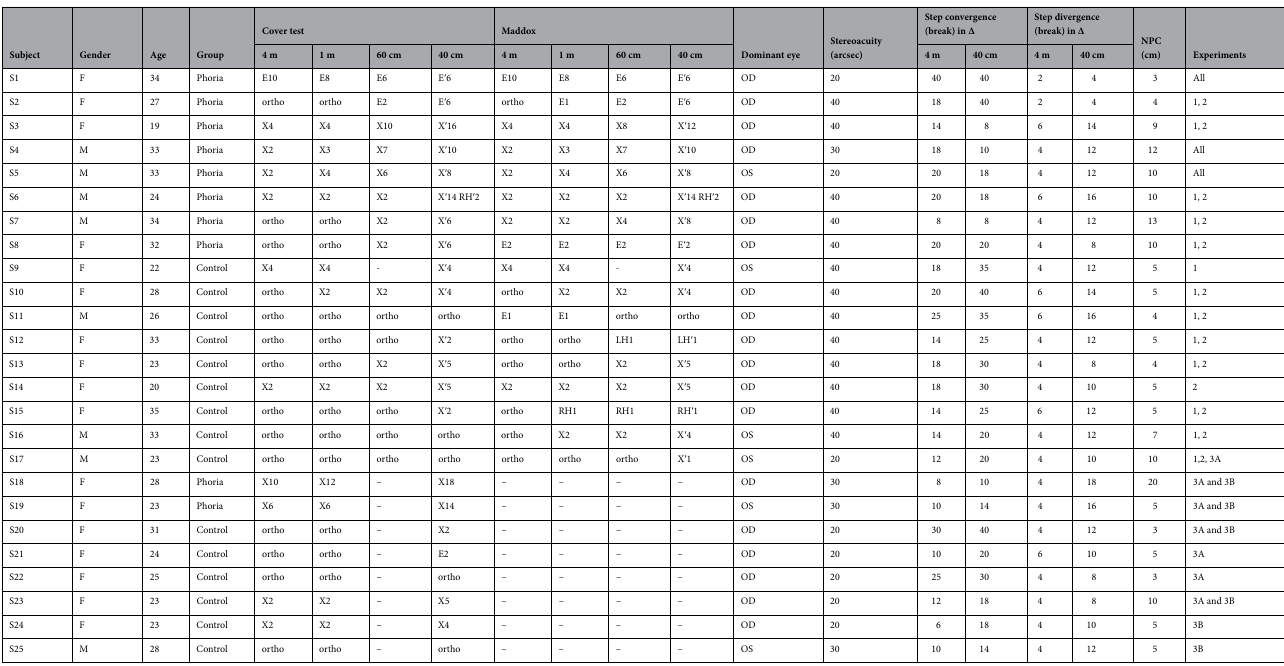
Table 1. Clinical orthoptic details on the enrolled subjects. F female, M male, ortho orthophoria, X exophoria, E esophoria, RH right hyperphoria, LH left hyperphoria, OD right eye, OS left eye, NPC near point of convergence, Δ prismatic diopter, cm